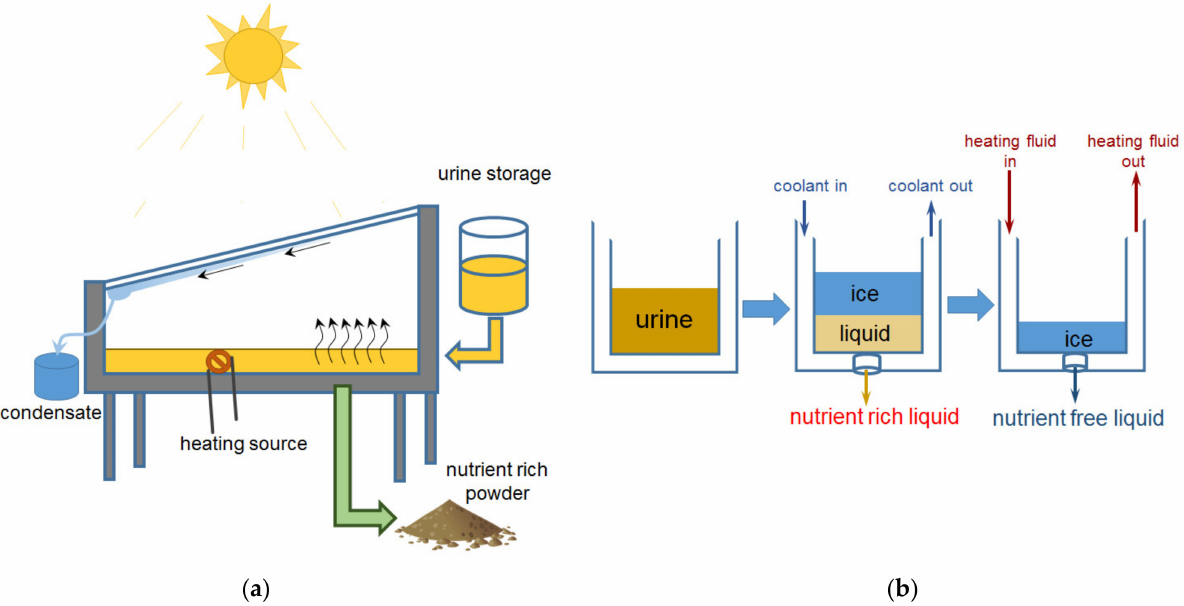
Figure 2. Concentration of liquids containing nutrients by evaporation ( a ) and lyophilization (freez- ing) ( b ). Based on